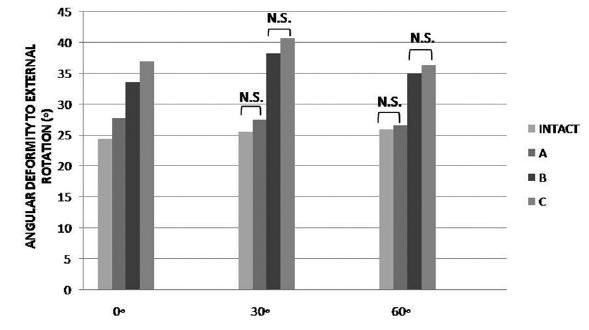
Figure 5 - Comparison of angular deformity to external rotation among groups with 0, 30 and 60 degrees of flexion. All values were significant, except where notated N.S. (not significant).